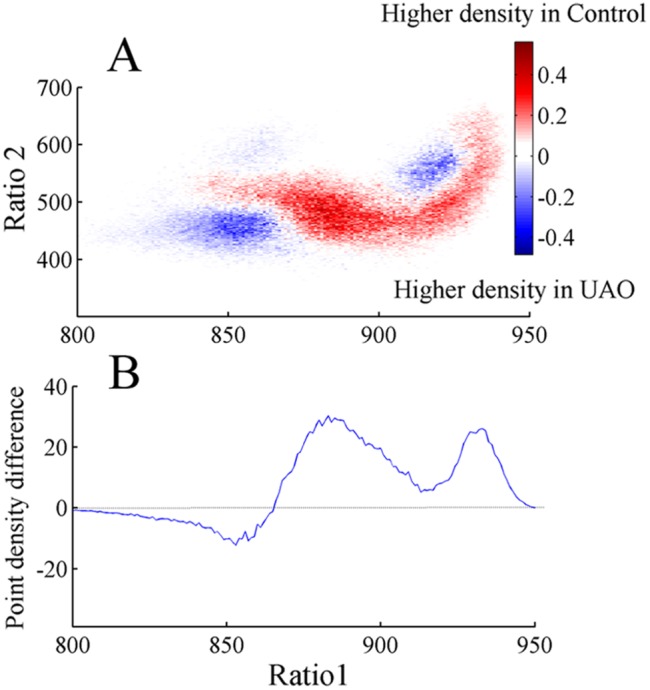
Difference plot showing average density pattern of UAO rats subtracted from control rats (A).B–projection of this graph into ratio 1. The color scale highlights differences between the groups: warm colors indicate regions where the average density is higher in controls and cool colors indicate higher density in UAO group.